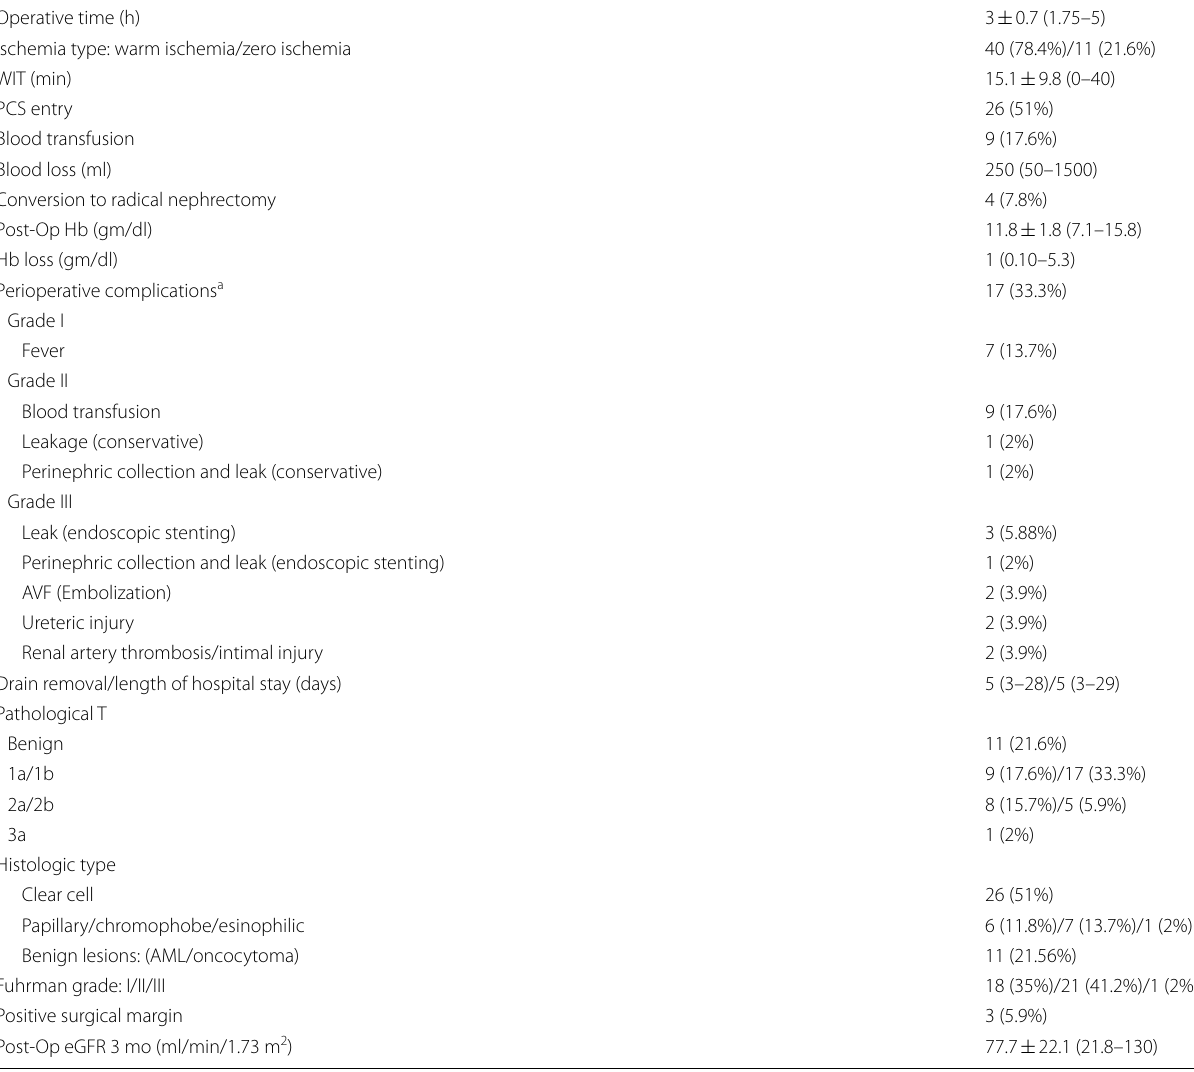
Values are presented as mean SD (range), median (range) or number of patients (%) as appropriate ± a According to Clavien-Dindo classification system